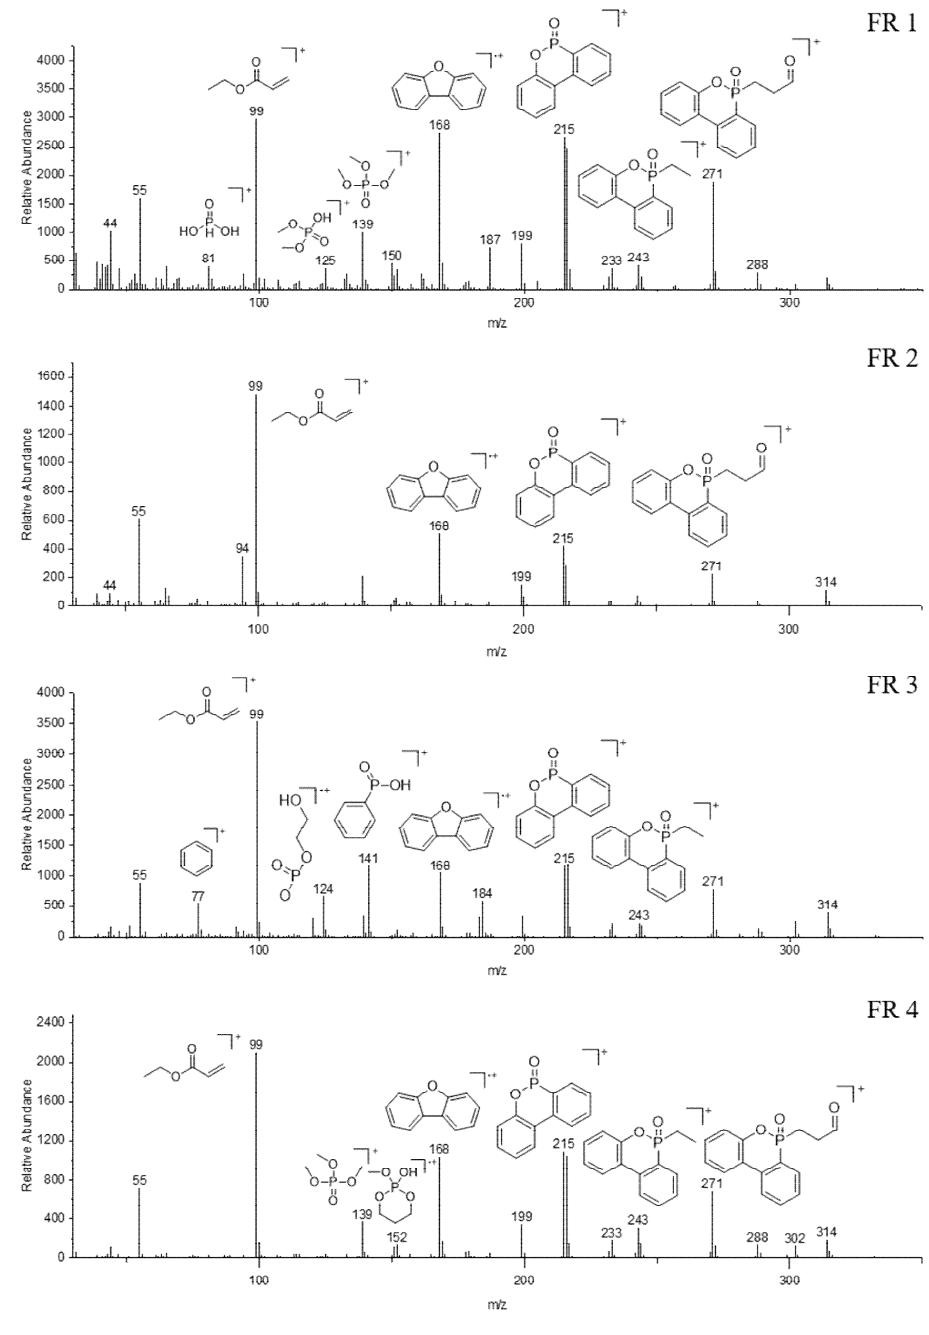
Figure 4. Mass spectra of FRs 1–4.